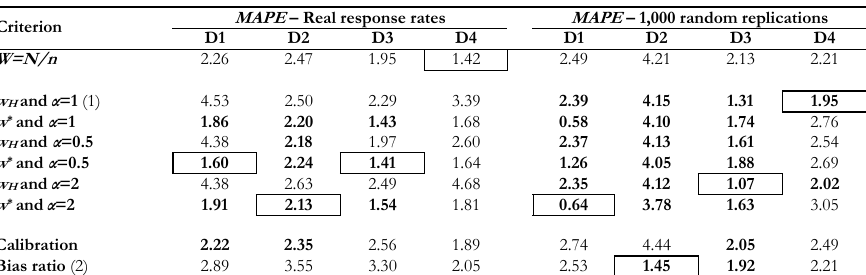
Comparison between results obtained using the real response rates and simulated 50% response rates (1,000 random replications 8 ); results derived from calibration and bias ratio criteria (retail trade: average of 2007